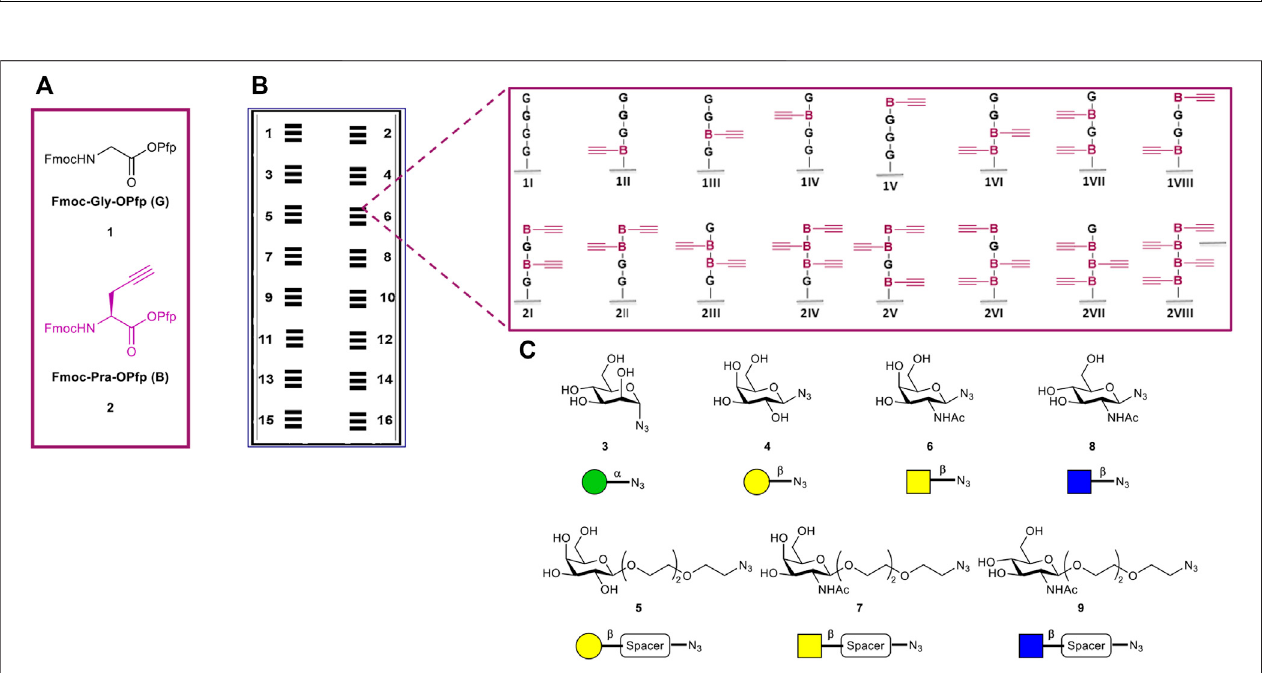
FIGURE2| Overviewoftetramerpeptidescaffoldsandsugarazides. (A) Thetwoaminoacidsusedforthesynthesisofthedesiredscaffolds. (B) Representationof the 16 synthesized microarrays per glass slide, each array containing three copies of the sixteen different tetramers in quadruplicate spots ( n (cid:2) 3 × 4 (cid:2) 12 spots of each structure per microarray). (C) Collection of sugar azides for the generation of the glycopeptides.